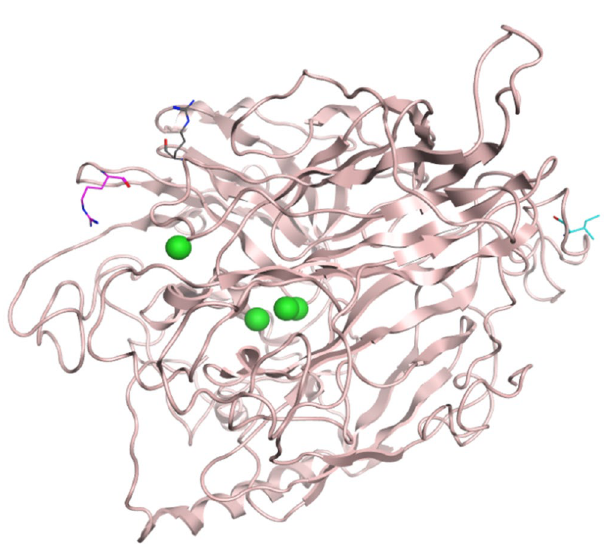
Figure 3. First ten residues with the highest energy of activation.